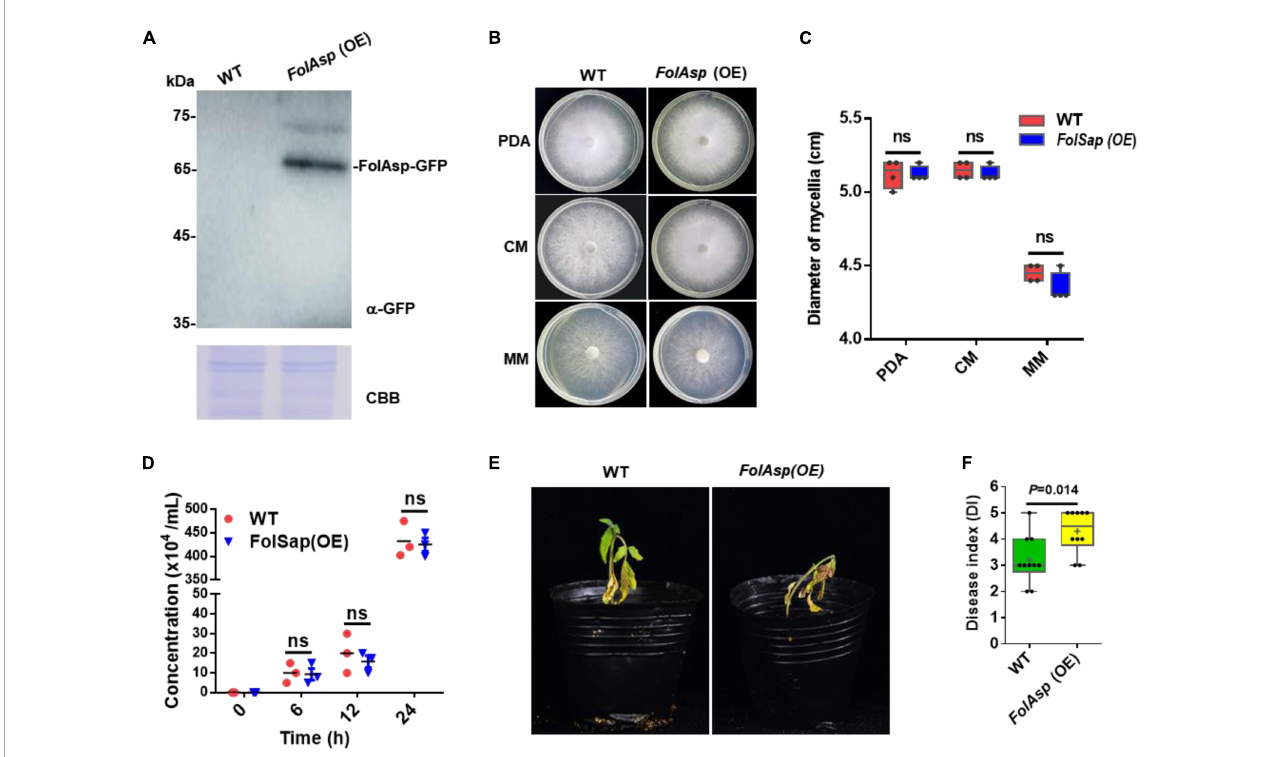
FIGURE3 FolAsp-GFP overexpression increases virulence. (A) FolAsp-GFP overexpression [FolAsp (OE)] in Fol was determined by Western blotting with anti-GFP antibody. The WT strain was used as the control. Protein loading is indicated by CBB staining. (B) Mycelial growth of the WT and FolAsp (OE) strains on PDA plates after 5 days of cultivation. (C) Mycelium diameters of colonies of the strains in panel (B) were measured at 5 days of cultivation. (D) Conidia production of the WT and FolAsp (OE) strains in PDB liquid medium at the indicated times. No significant difference (ns) was indicated according to multiple t -test. (E) Virulence of the WT- and FolAsp -overexpressed mutant strains on tomato. (F) Disease index scored at 14 DAI. For panels (E,F) the virulence and disease index were determined as in figure.